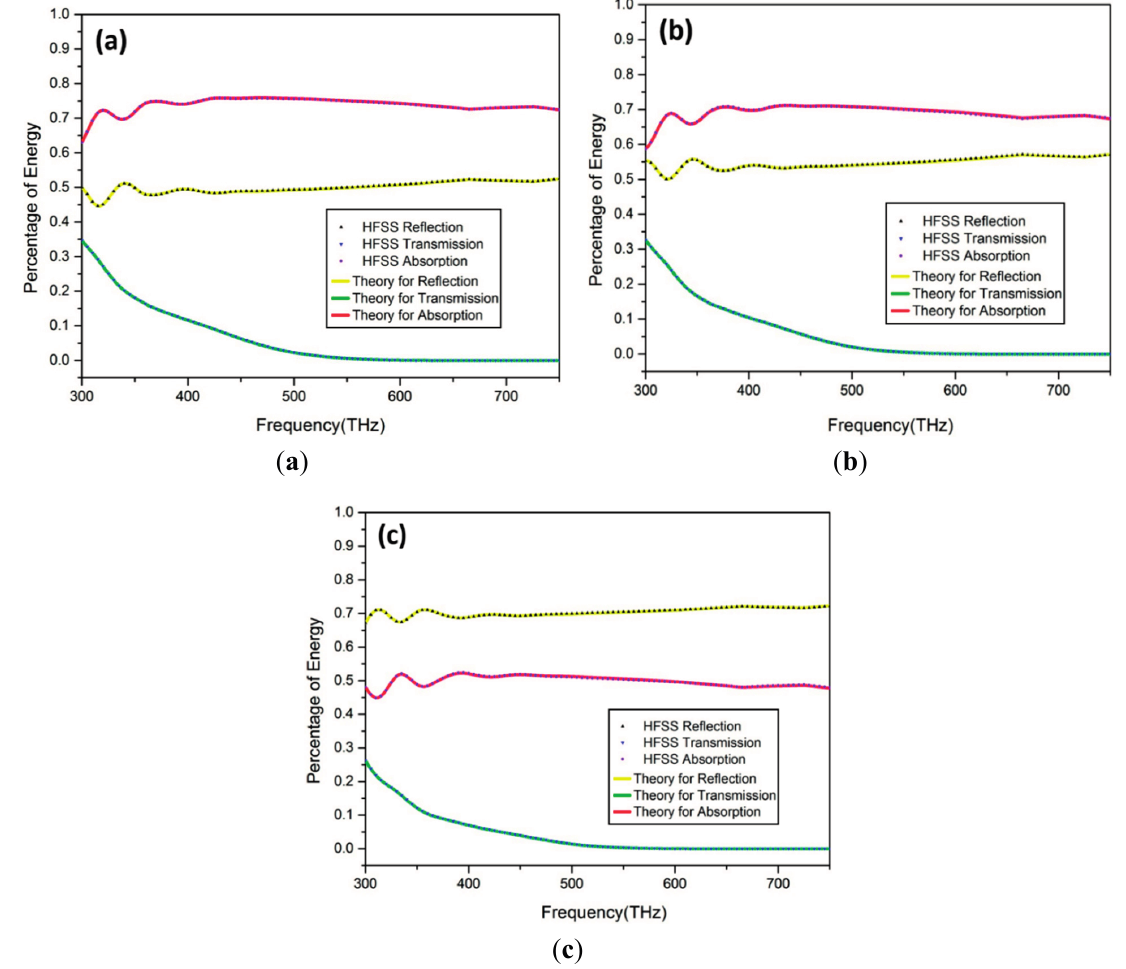
Figure 4. Theoretical and numerical results of the reflection, transmission and absorption of the five-layer thin film solar cell under ( a ) 0°. ( b ) 30°. ( c ) 60° angle of